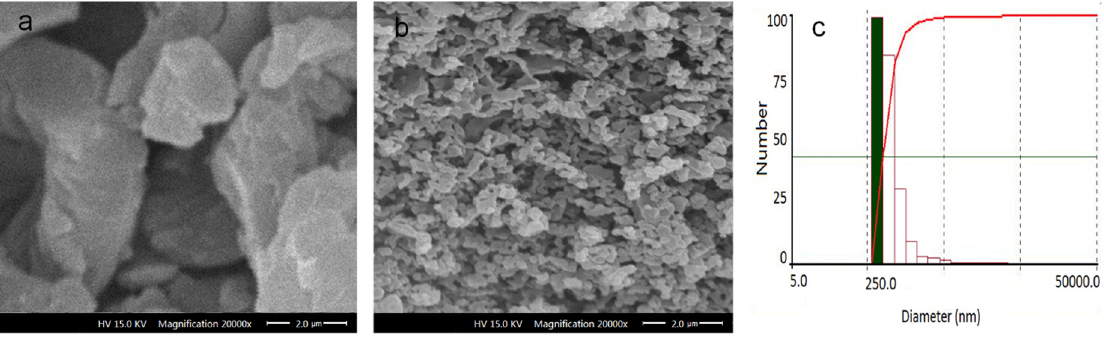
Figure 9. Dissolution profiles of unprocessed and processed spiramycin (spiramycin microparticles are the micronized spiramycin by homogenate ‐ antisolvent precipitation under optimum conditions). 5. Conclusions In the six parameters that affect the HAP micronization of spiramycin, spiramycin concentration, the volume ratio of antisolvent to solvent, and the dripping speed of the solvent adding into the antisolvent have a significant effect on the MPS of micronized spiramycin, but the other three factors contributed an insignificant effect. According to the evaluation using BBD, the MPS of the processed